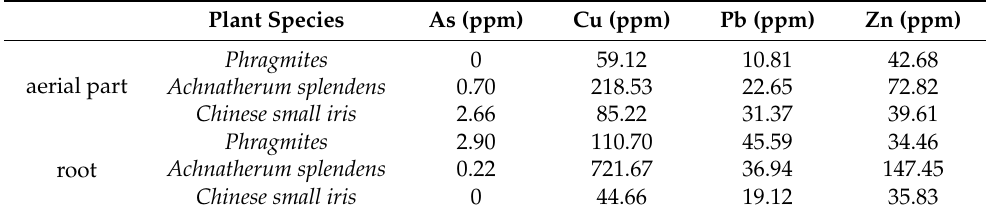
Figure 1. Location of the trial site and site division: ( a ) panoramic view of experiment site; ( b ) division of different stabilization zones in the trial site; and ( c ) distribution of sampling units.